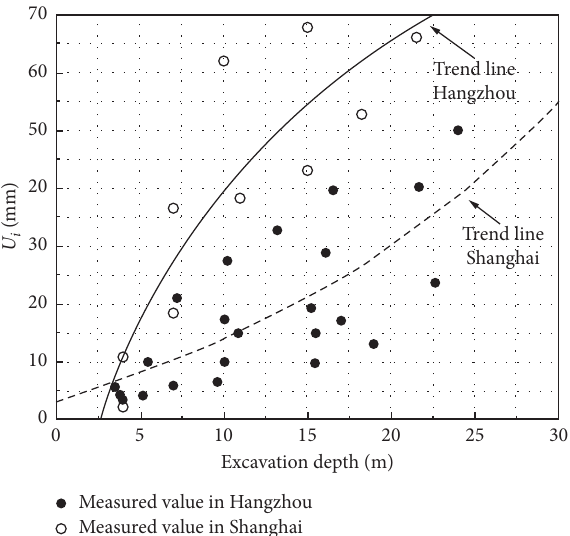
Figure 8: Relationship between excavation depth and maximum lateral deformation within excavation